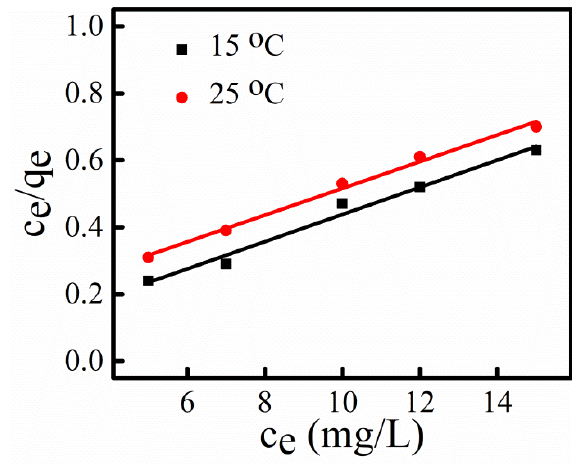
Figure 8. Langmuir isotherm plot for adsorption of MB dye at two different temperatures.